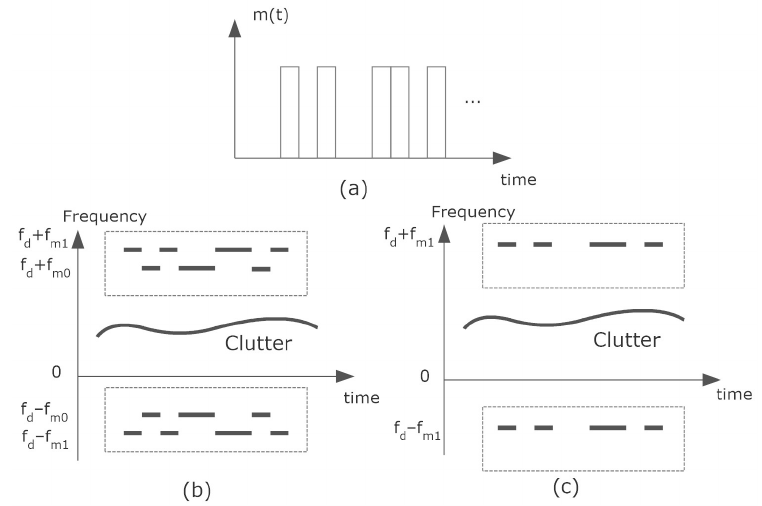
Figure 11. Diagram of spectrograms received ( a ) when modulating with the sequence m ( t ) , spec- trogram received if modulated in ( b ) FSK and ( c ) ASK. The dashed lines indicate the region of the window used to search for modulation